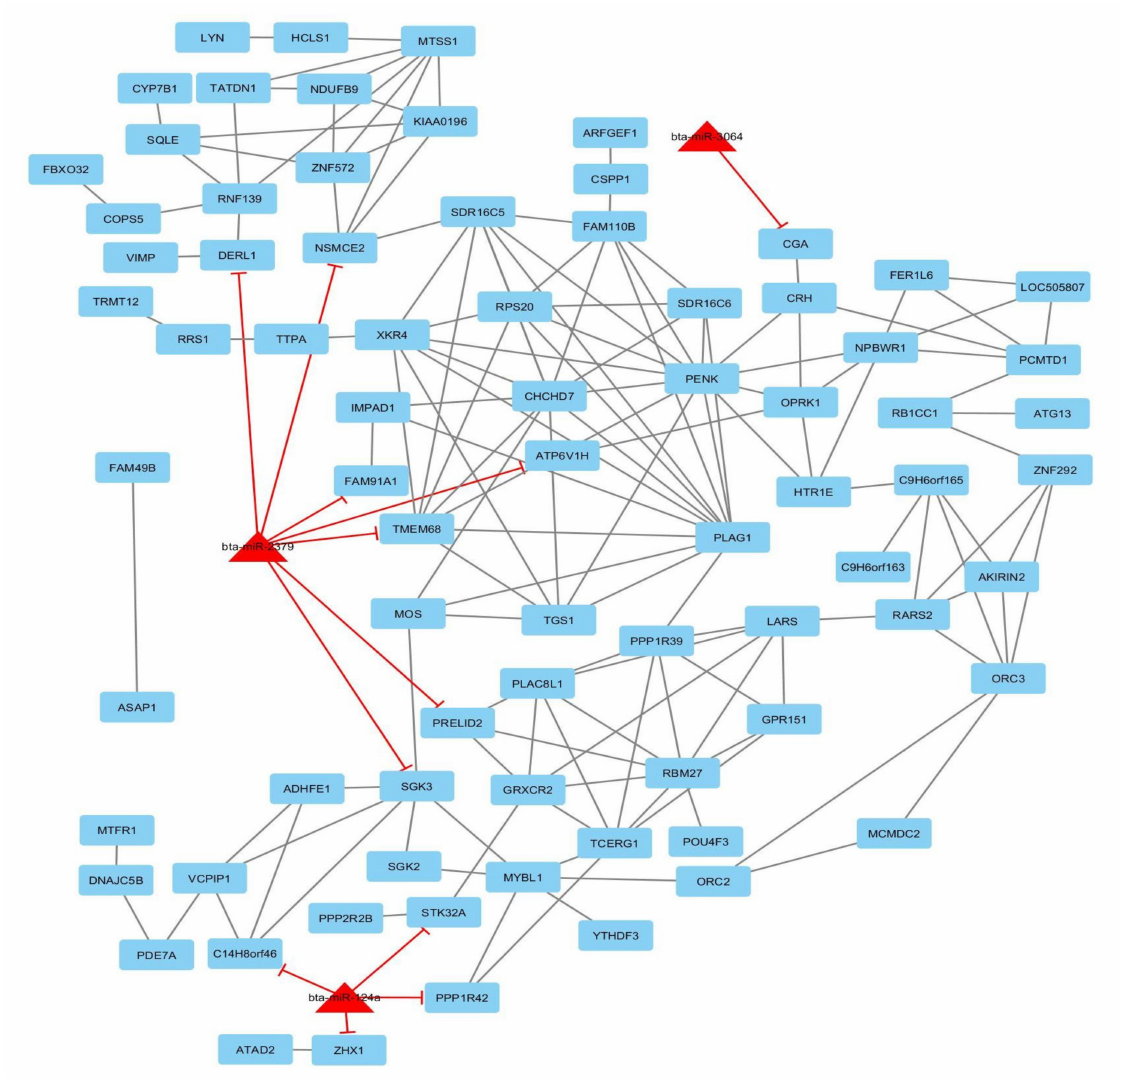
Figure 4. The network of carcass weight related genes and miRNAs using Cytoscape software (version 3.7.2; www.cytoscape.org); each node denotes a gene (rectangle) and miRNA (triangle) and edges depict miRNA–gene